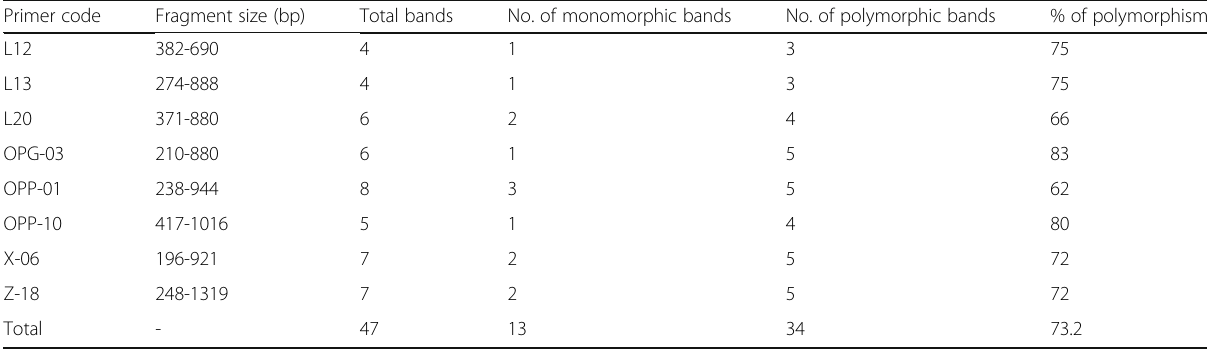
Table 5 Total bands, number of monomorphic and polymorphic bands, and the percentage of polymorphism of selected eight RAPD primers among the 14 studied samples of Silybum marianum Primer